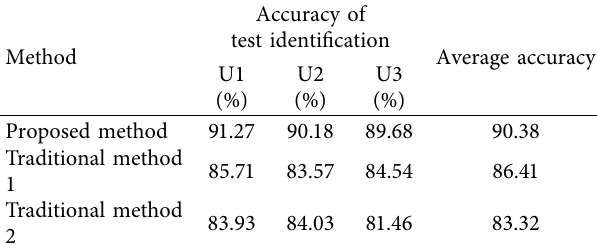
Table 3: Comparison of multistring malfunction identification accuracy.